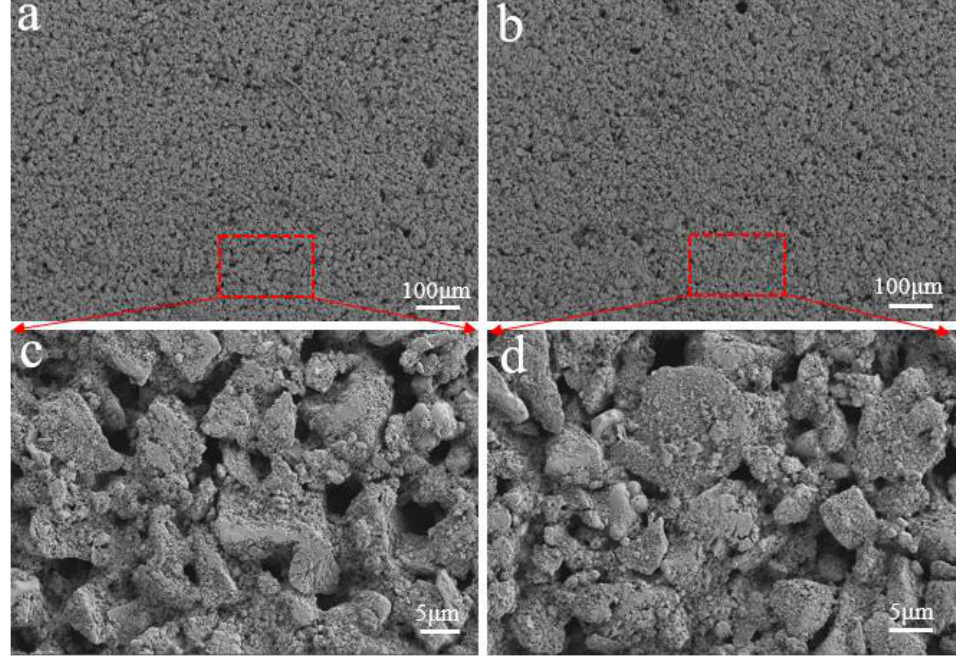
Figure 8. Surface microstructure of LiMn 2 O 4 composite electrode during the third cycle ( a , c ) fully delithiated ( b , d ) and fully lithiated at different magnifications.